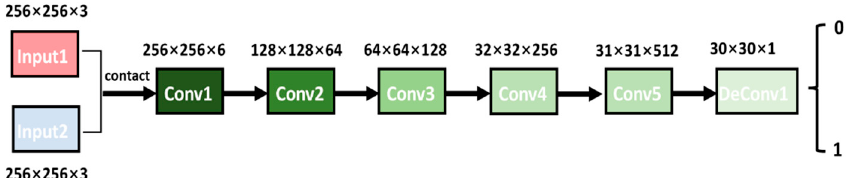
Figure 4. Underwater image enhancement network discriminator. The basic unit structure of the discriminator part was the same as that of the generator part, and the input of the discriminant network was two 3-channel RGBs.